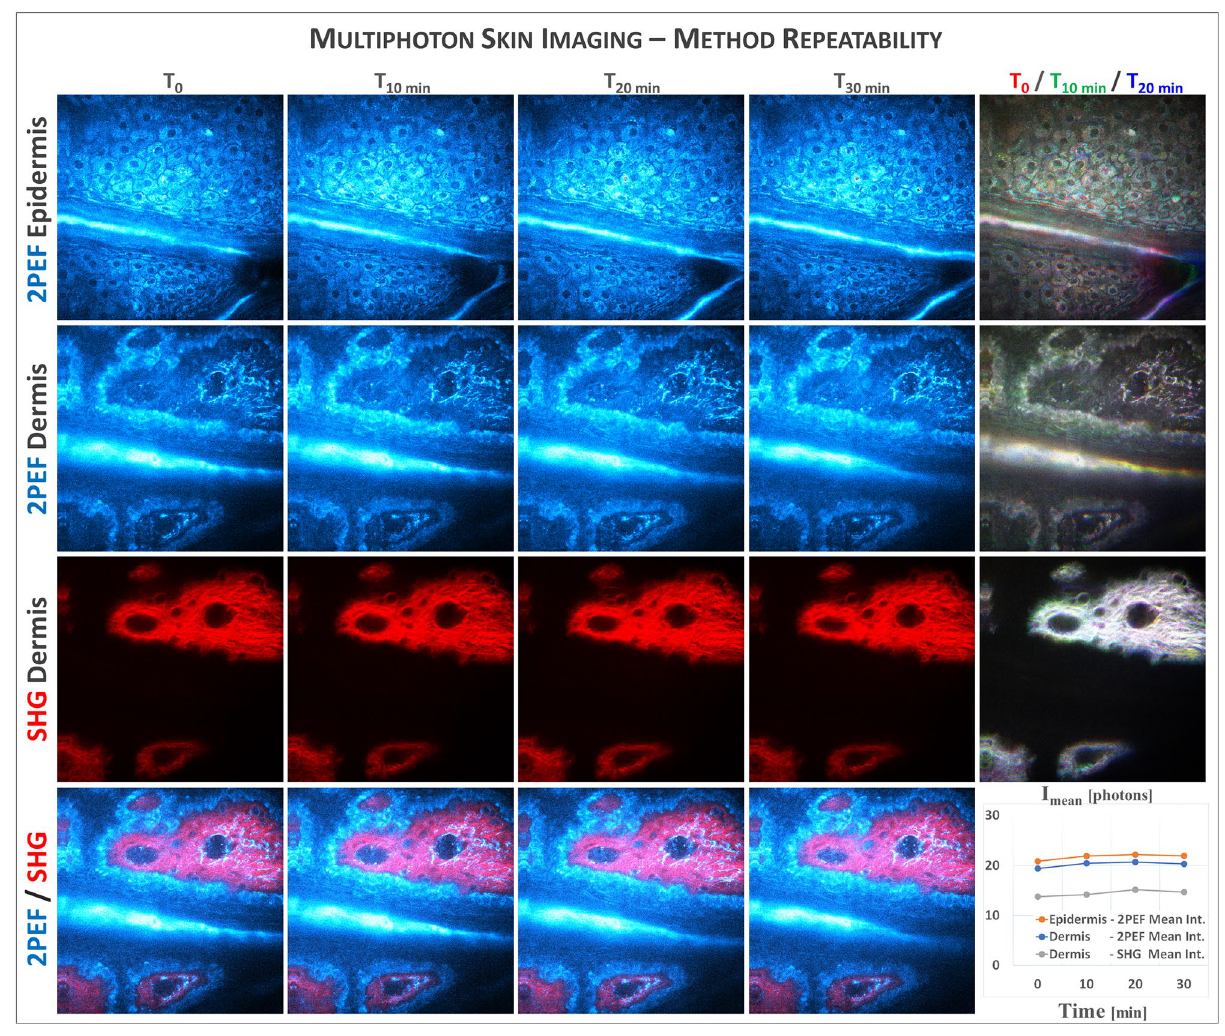
Figure 2. Multiphoton 3D imaging method repeatability—live imaging of human ventral forearm skin recorded every 10 min. Multiphoton 2PEF, SHG and combined 2PEF (cyan hot color)/SHG (red color) images of epidermis and dermis are extracted from a z, t-stack acquired every 2 µm from the skin surface to the dermis and respectively every 10 min within the same skin region and with identical experimental conditions. The right panel images, a combination of images acquired at t = 0 min (red color), t = 10 min (green color) and t = 20 min (blue color) allow observing the time frames colocalization (white when perfect colocalization). The graph shows very slight changes overtime in the mean 2PEF and SHG signals intensity within epidermal and dermal layers, due to slight volunteer